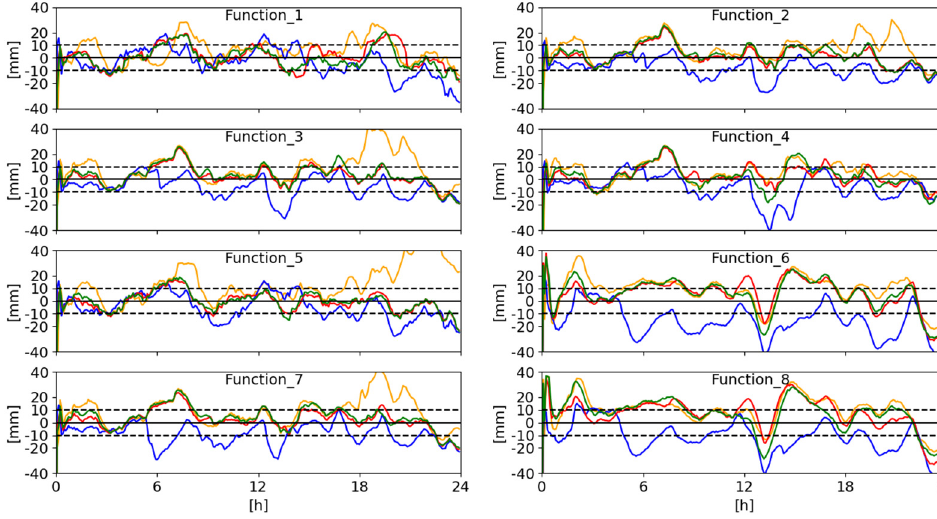
Figure 5. Time series of U component, 2D and 3D errors for the first four hours for the weighting functions. Functions 5–8 for the MAS100ESP station for the 39 DoY for all solutions. Blue—E solution, orange—G solution, red—GE solution, green—GE1 solution.